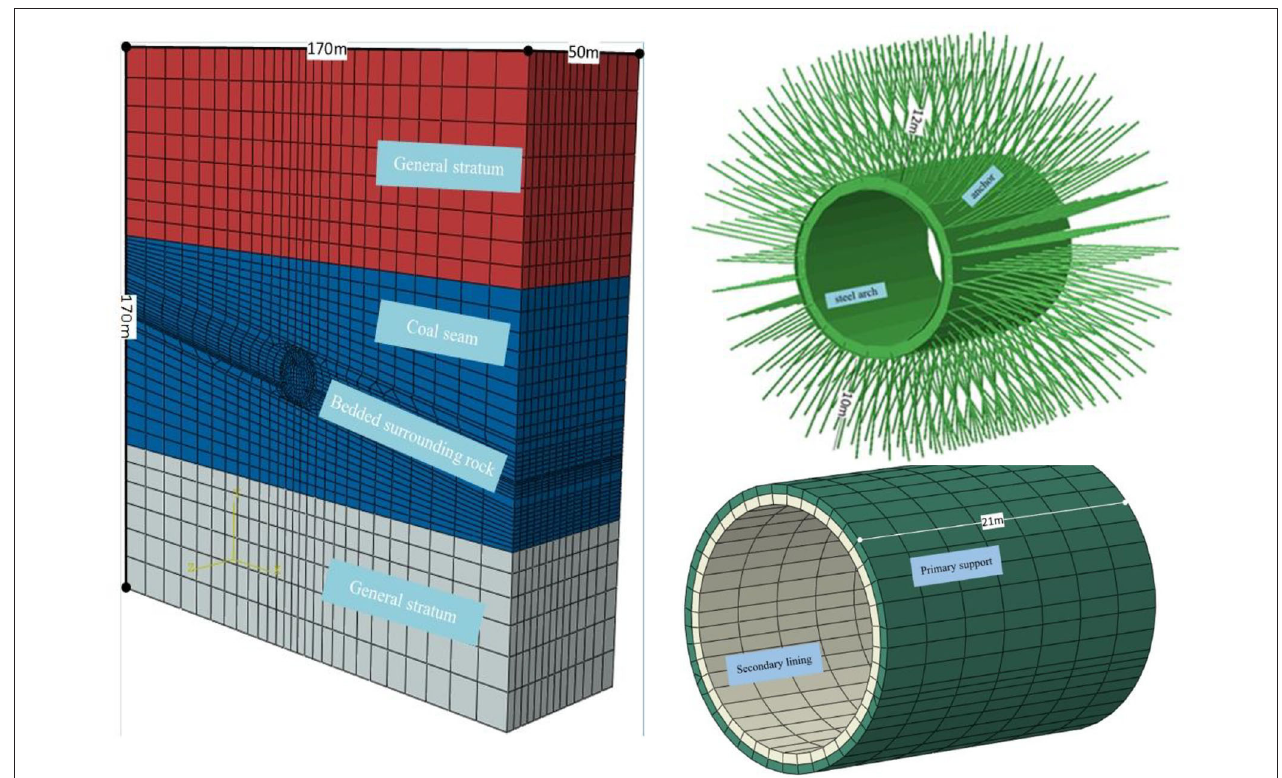
FIGURE 5 | The numerical model and the element mesh.